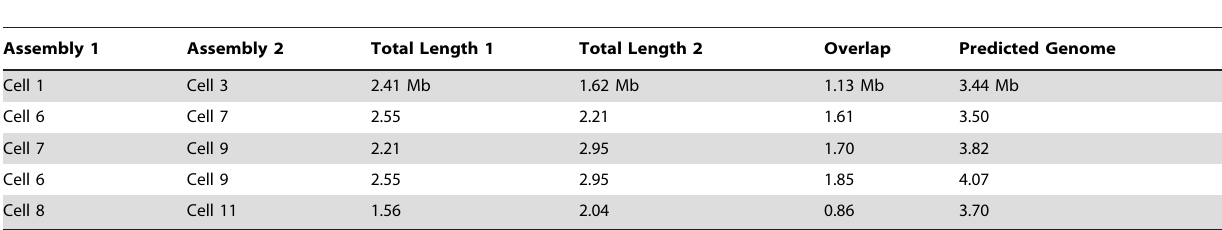
Table 2. Prediction of Tannerella BU063 full genome size based on overlap of partial